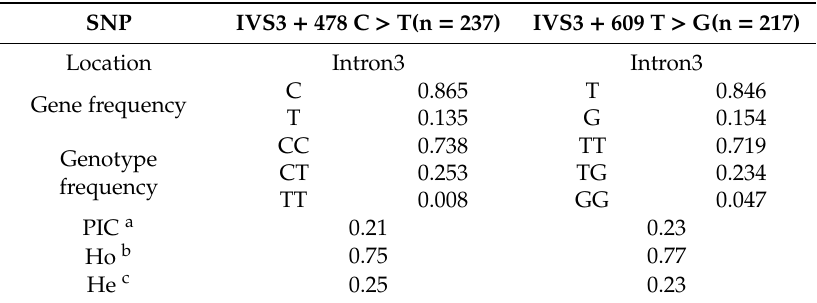
Figure 7. Detection and genotyping of Single‐nucleotide polymorphism sites (SNPs) of the DLK1 gene